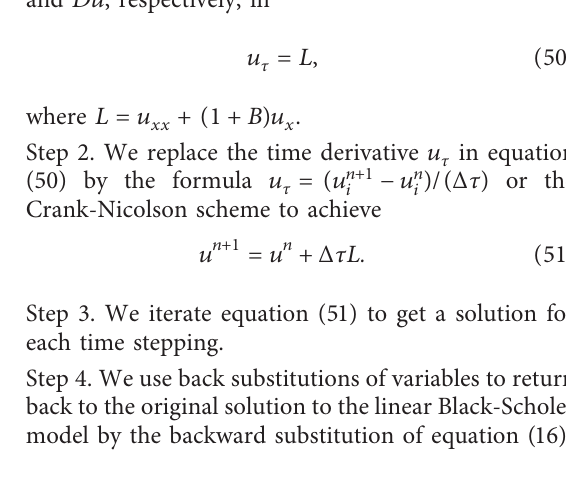
Algorithm 2. The linear BS